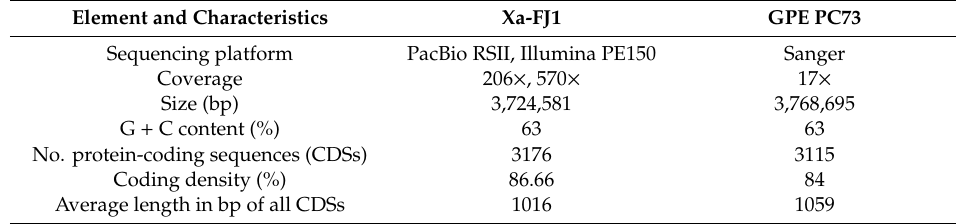
Table 1. General chromosomal features of X. albilineans strains Xa-FJ1 from China and GPE PC73 from